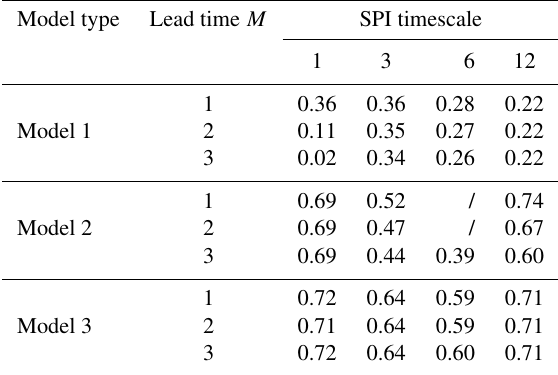
Table 5. Model evaluation (Model 1: multivariate normal distribu- tion model; Model 2: conditional distribution model; Model 3: con- ditional distribution model with the